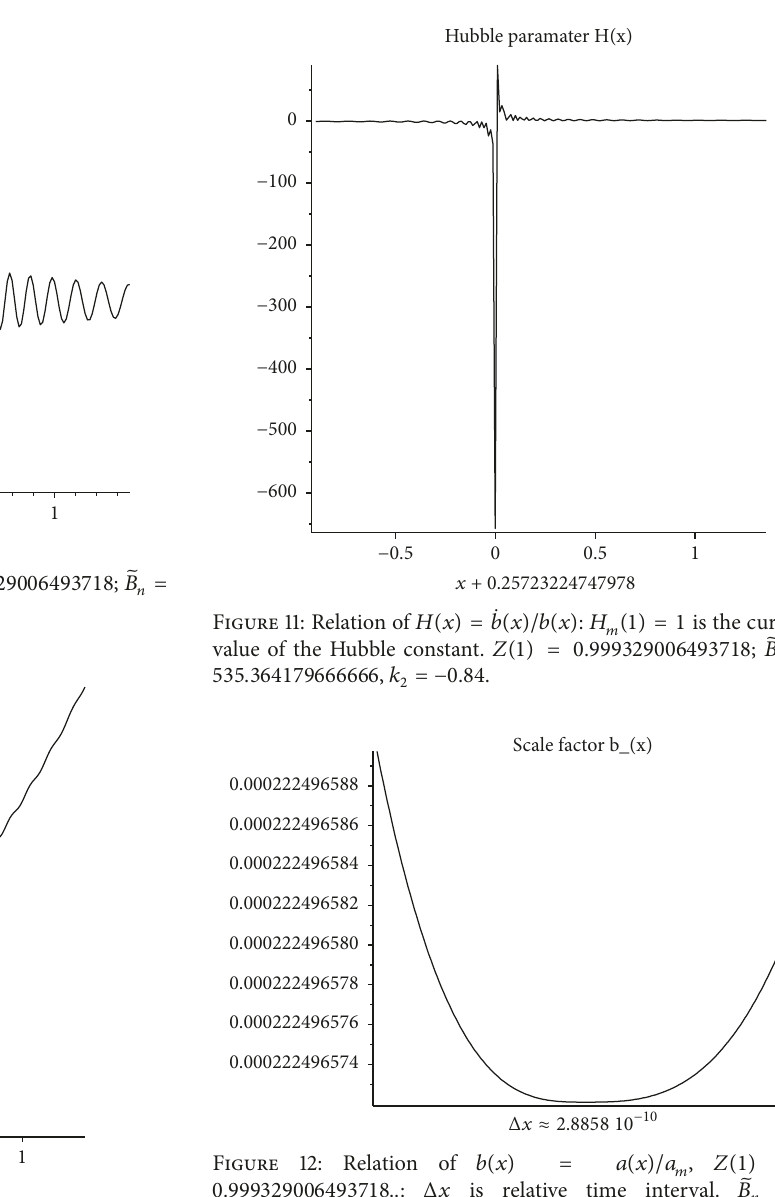
Figure10:Relationof 𝑏(𝑥) = 𝑎(𝑥)/𝑎 𝑚 , 𝑍(1) = 0.999329006493718.. ; ̃𝐵 = 535.364179666666 , 𝑘 𝑛